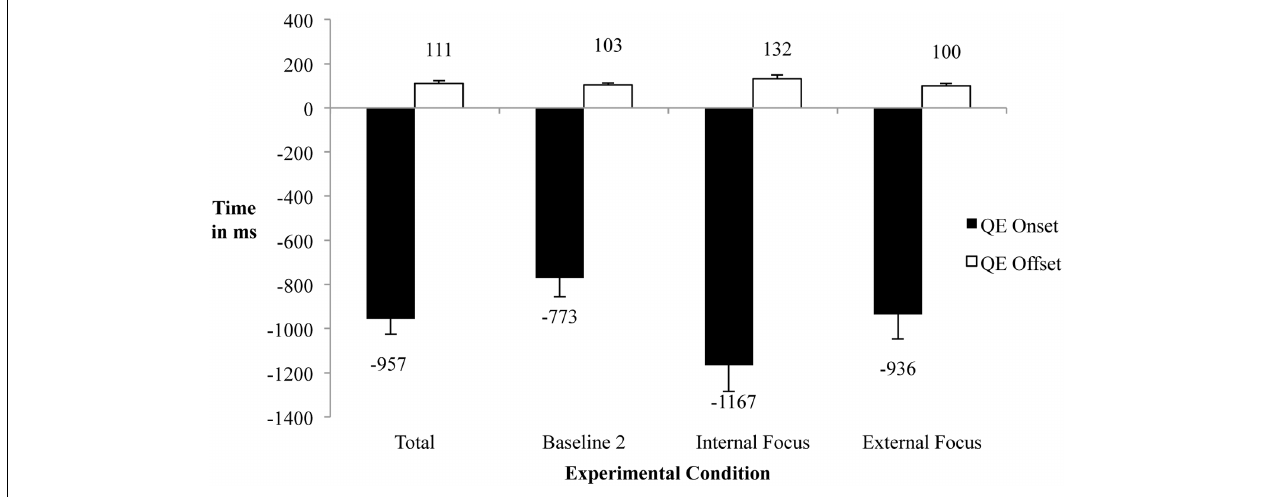
FIGURE 2 | QE onset, offset, and duration for each condition and overall. Measurement in milli-seconds; 0 is the first moment the throwing arm accelerates toward the dart board; error-indicators depicted are standard errors of the